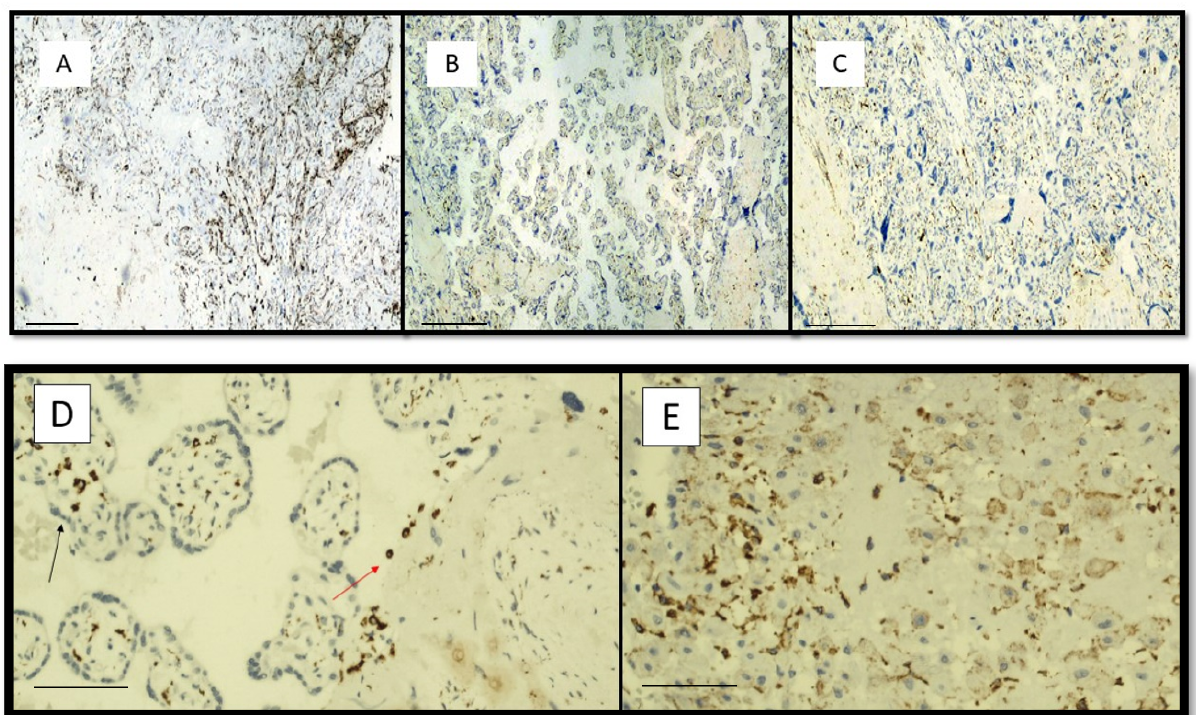
Figure 4. Examples of immunostaining with anti-CD68 antibody (PGM-1) in chorionic discs from CIC ( A ), CNIC ( B ) and control ( C ) groups. (( A ), Original Magnification: 4 × , scale bar: 700 µ m. ( B , C ), Original Magnification: 10 × , scale bar: 700 µ m). ( D ) Photomicrograph showing the presence of